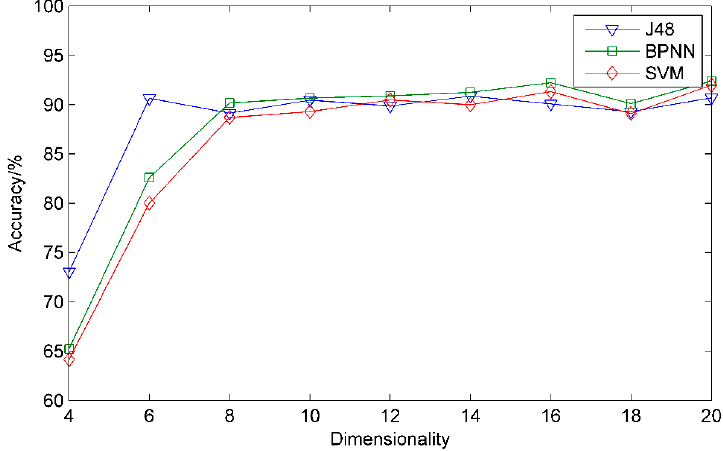
Figure 3. The classification accuracy under different dimensionalities.